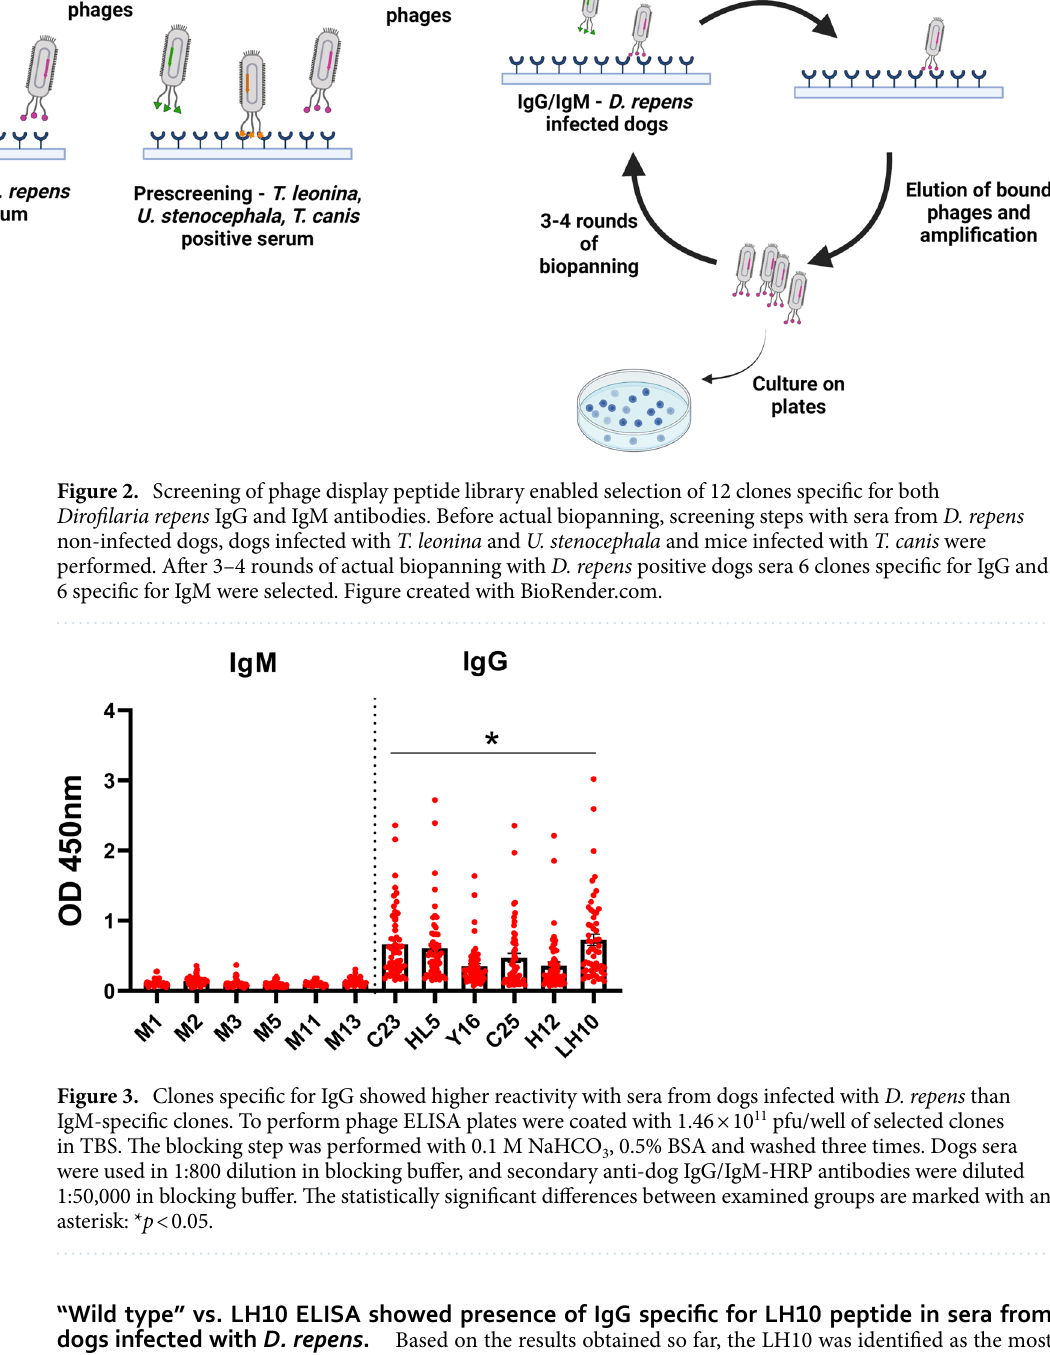
“Wild type” vs. LH10 ELISA showed presence of IgG specific for LH10 peptide in sera from dogs infected with D. repens . Based on the results obtained so far, the LH10 was identified as the most reactive and promising peptide. To exclude potential non-specific reaction of tested sera with native phage pro- teins, we designed phage ELISA with LH10 phage clone versus “wild” M13 phage (a clone with no library insert sequence). The OD values of IgG observed for LH10 clone were significantly higher than those observed for “wild” phage, suggesting the occurrence of antibodies specific for displayed peptides (Fig. 6).